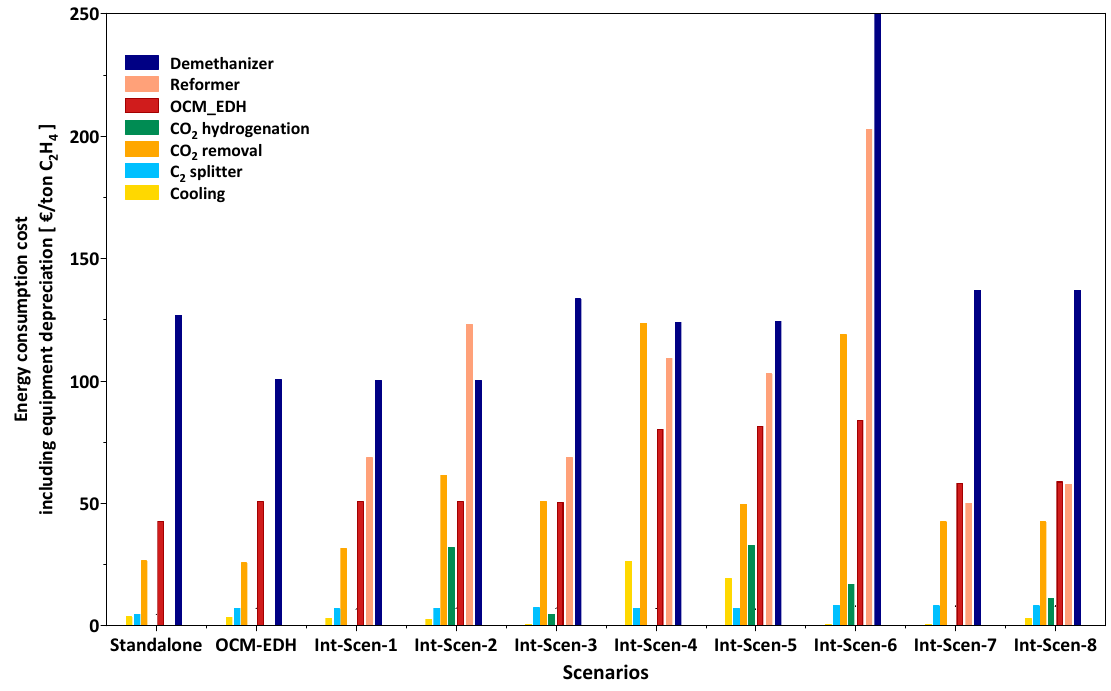
Figure 3. Section-wise “Energy Consumption Cost” for the investigated process scenarios (the process scenario numbers are according to Table 3).